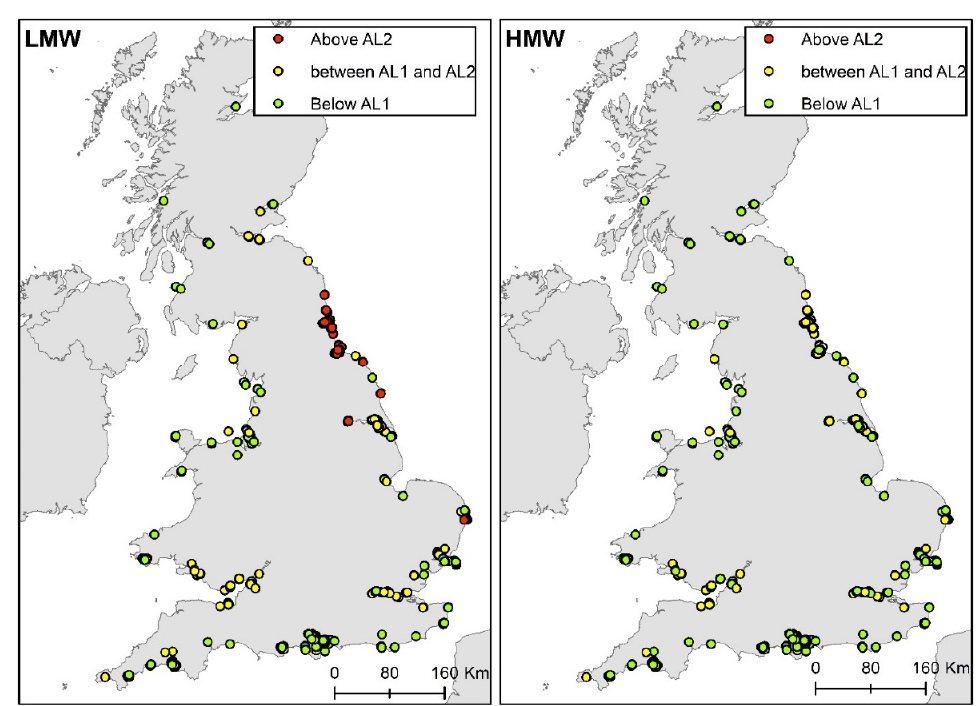
Figure 8. Maps showing ERLs (AL1) and ERMs (AL2) for LMW and HMW [15] summed PAHs (Table 12). Samples above AL2 are indicated in red. Figure adapted from [13].